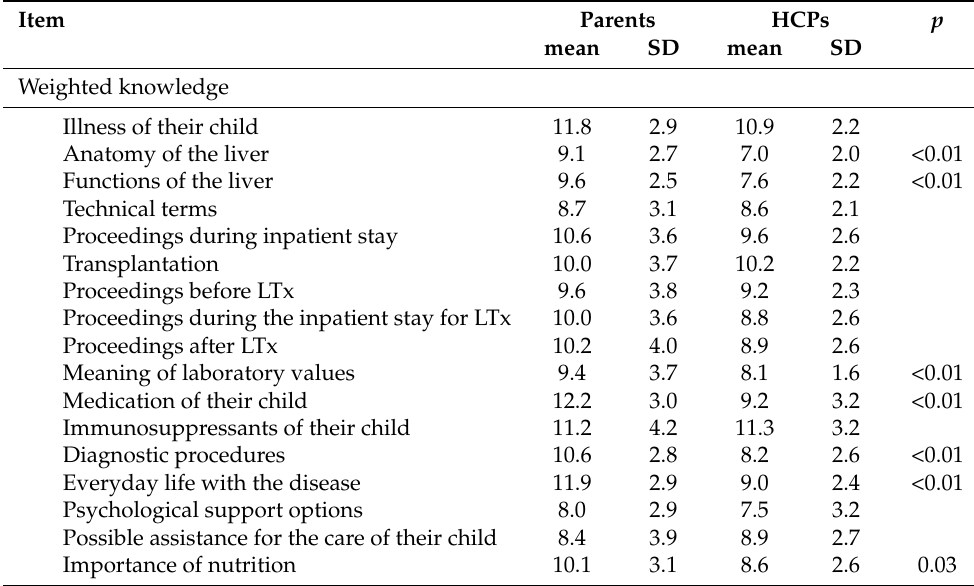
Table 5. Knowledge weighted by importance as assessed by parents and